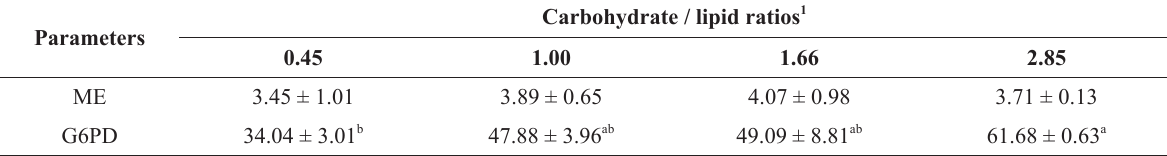
Hepatic enzyme activity of the juvenile Pseudoplatystoma ssp. fed the experimental diets for 60 days. The means in the same row with different superscripts are significantly different at